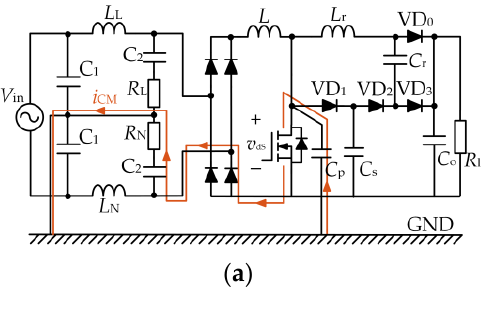
Figure 3. Conduction of CM EMI: ( a ) Positive half-cycle of input voltage and ( b ) Negative half-cycle of input voltage.